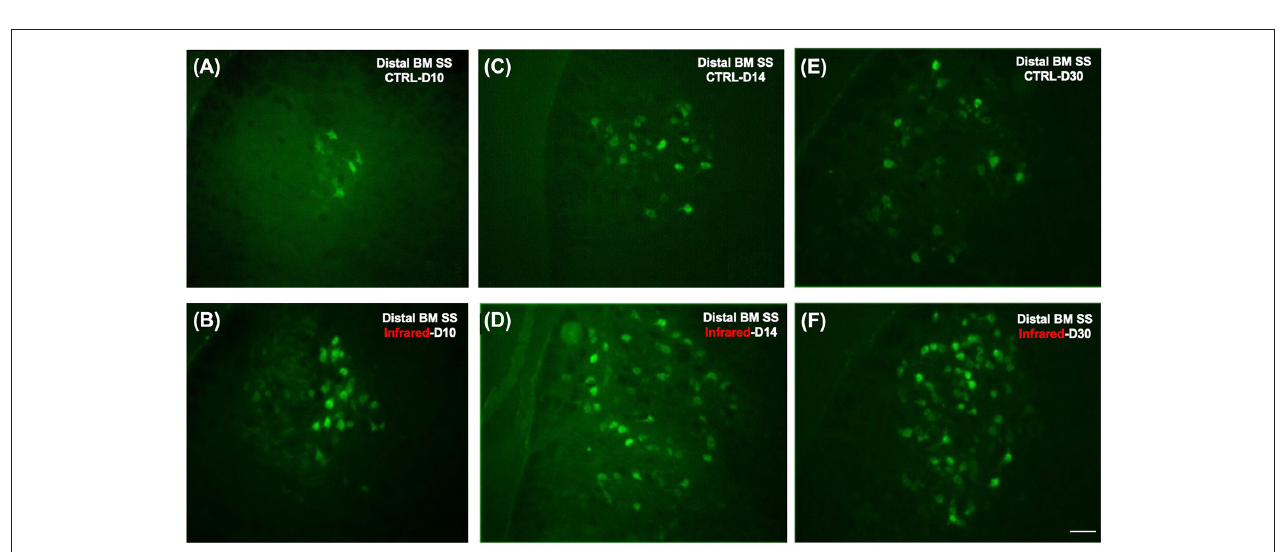
FIGURE 5 | Scores for eyelid closure on the injured side (left) at various time points after surgery. : animals subjected to proximal section-suture of the buccal branch without treatment ( n = 8), : injured nerve (proximal section-suture of the buccal branch) with IR treatment ( n = 8). Note the significant difference between treated and untreated mice (complete recovery of eyelid closure at D20 for treated mice and D50 for untreated mice). [*( p < 0.05) **( p < 0.01); one-way ANOVA].